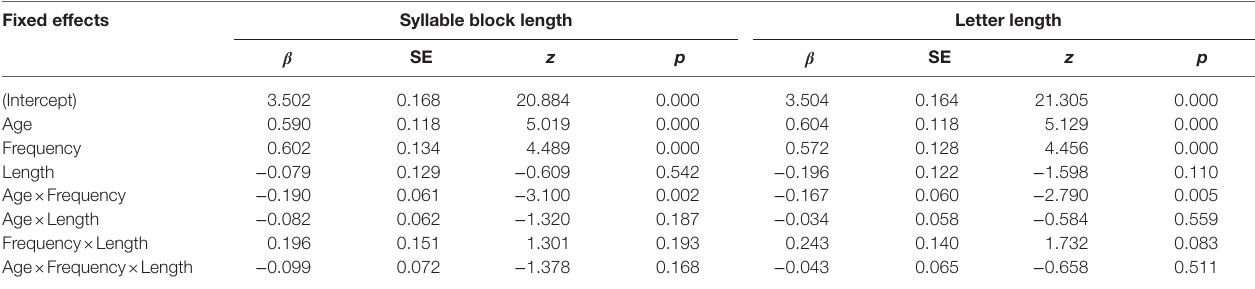
TABLE 5 | Estimates of fixed effects in reading accuracy: age × frequency × length on words.